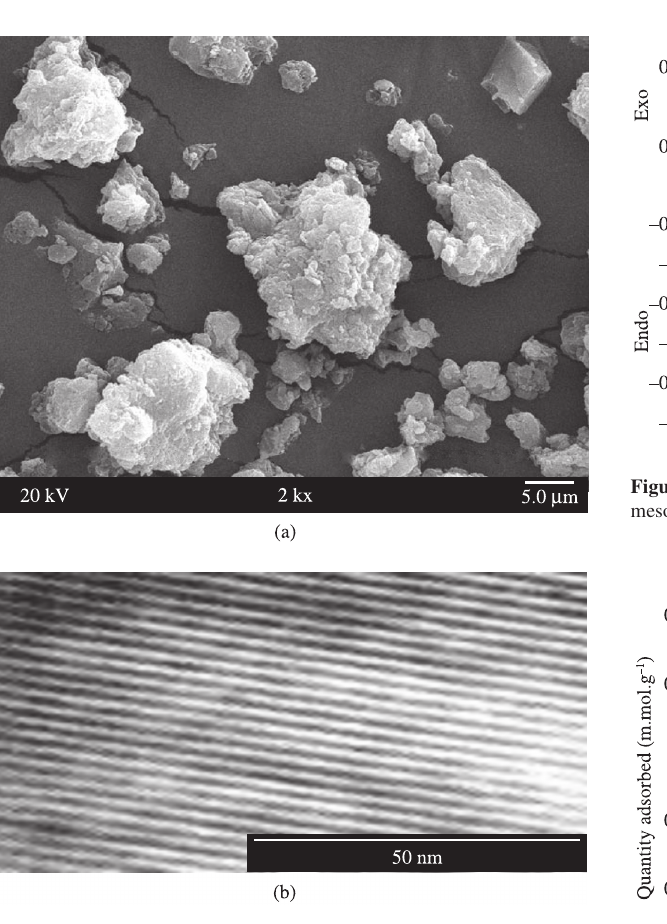
Figure 2. a) Scanning electron micrograph and b) Transmission electron micrograph of mesoporous Mn – organophosphate molecular sieve.